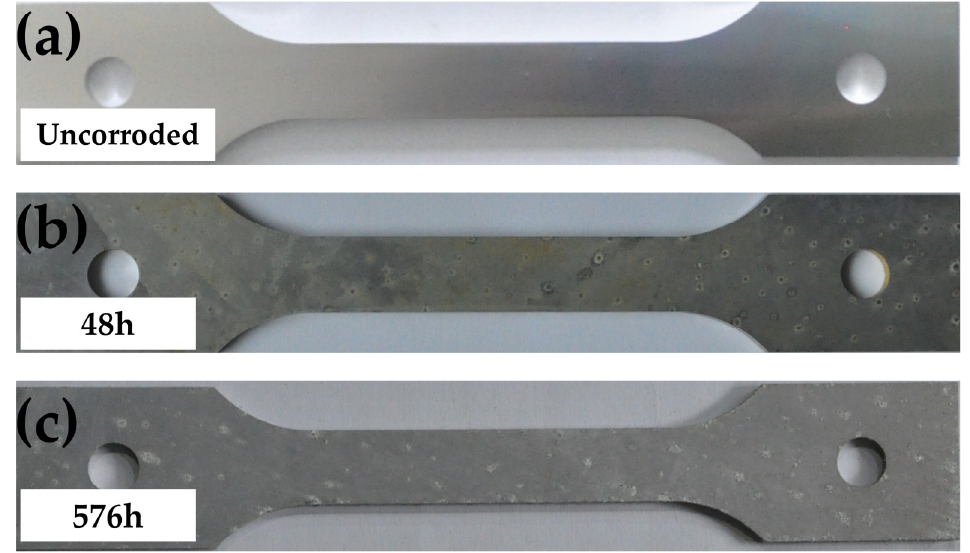
Figure 3. The surface morphology of uncorroded ( a ), corroded for 48 h ( b ), and 576 h ( c ) of the specimen of the 7B04-T74 aluminum alloy.